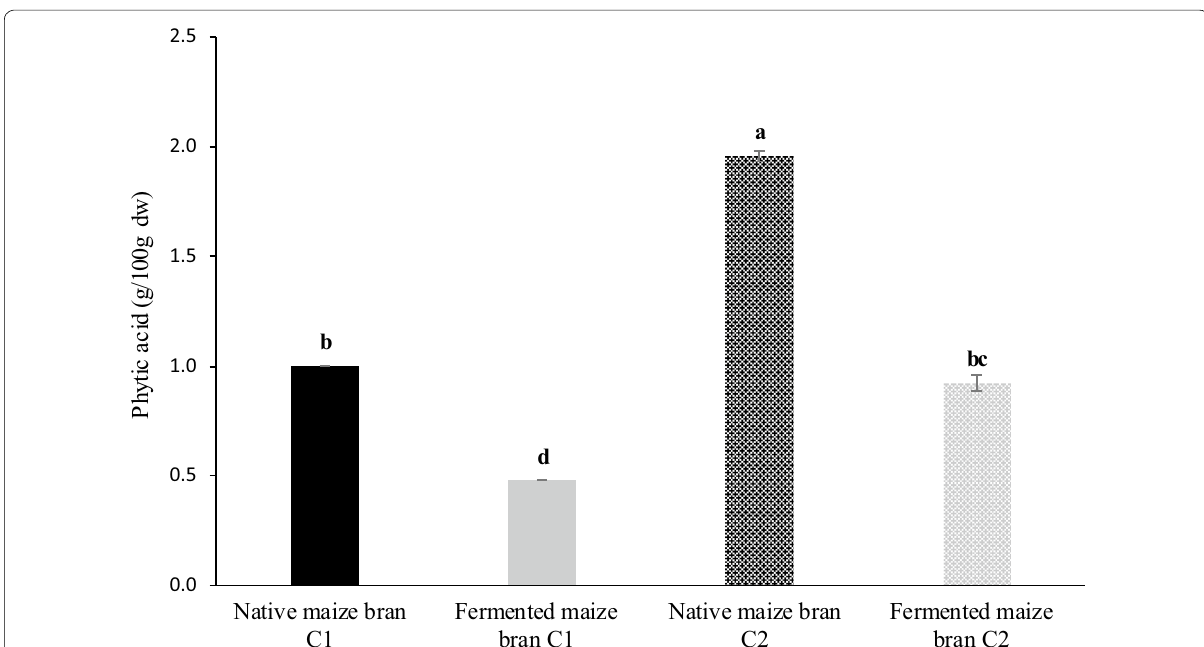
Fig. 5 Phytic acid (mean SD; expressed as g/100 g of dry weight) content in native and fermented (refreshment 12) brans. Bars not sharing com- ± mon letters are significantly different ( p <